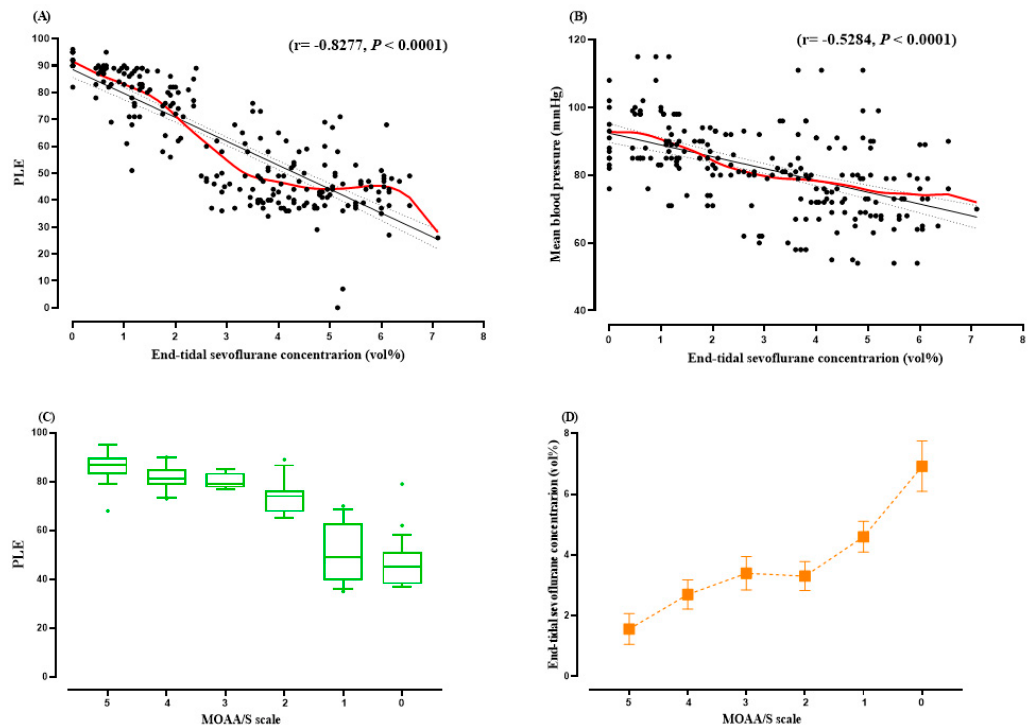
Figure 1. ( A ) Correlation between phase lag entropy, ( B ) mean blood pressure, and end-tidal sevoflurane concentration during sevoflurane anesthesia. ( C ) Plot of the modified observer’s as- sessment of alertness/sedation scale and phase lag entropy. ( D ) End-tidal sevoflurane concentra- tion corresponding to each modified observer’s assessment of alertness/sedation scale.